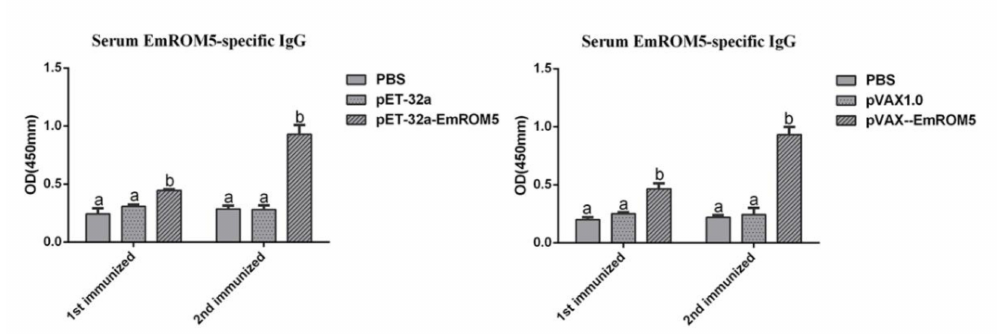
Figure 5. Serum EmROM5-specific IgG levels after immunization with rEmROM5 and pVAX– EmROM5 ( n = 5, value = mean ± SD). Significant difference ( p < 0.05) between numbers with different letters, and no significant difference ( p > 0.05) between numbers with the same